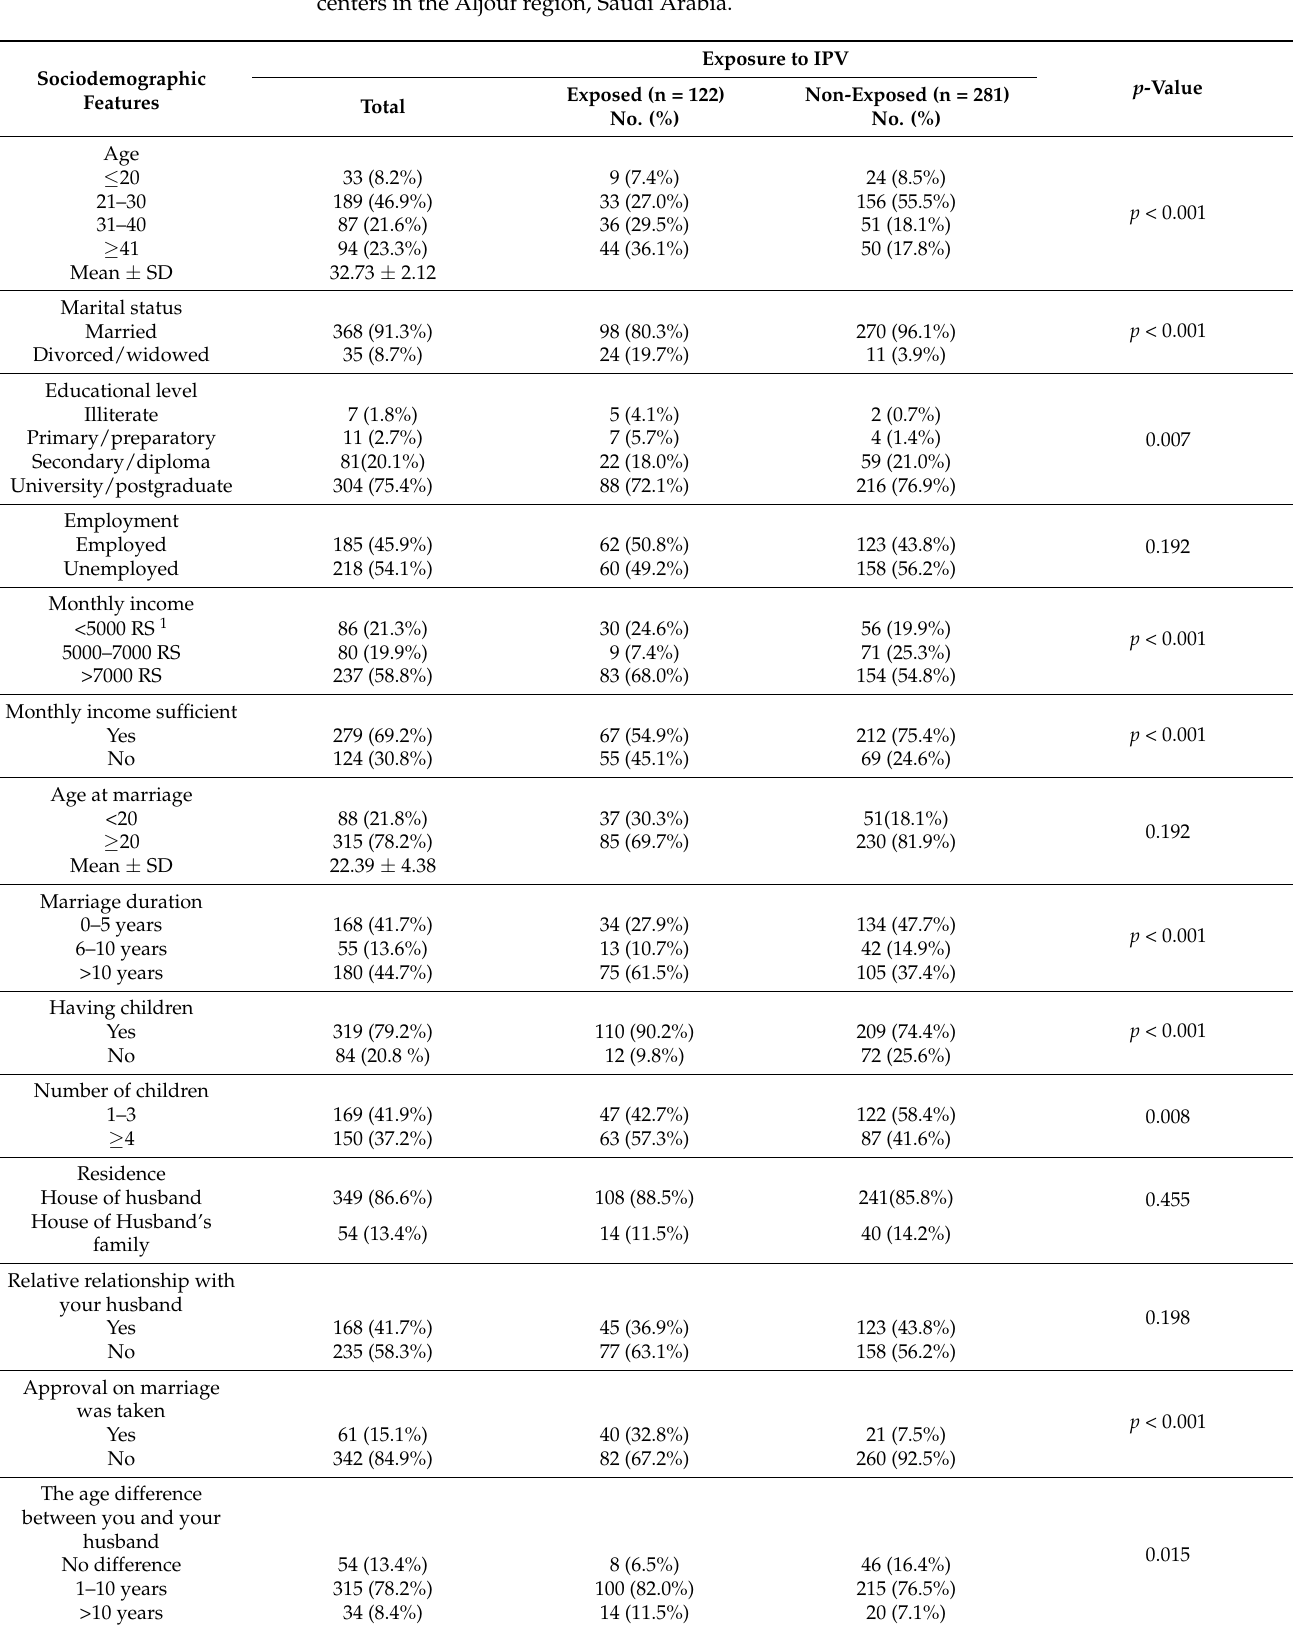
Table 2. Sociodemographic correlates of IPV among women attending different primary health centers in the Aljouf region, Saudi